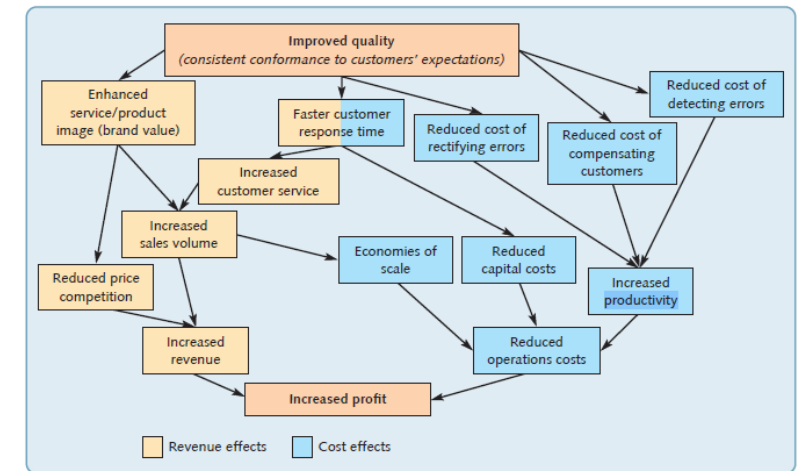
Figure 1: Quality Effect; Source: Slack & Brandon,